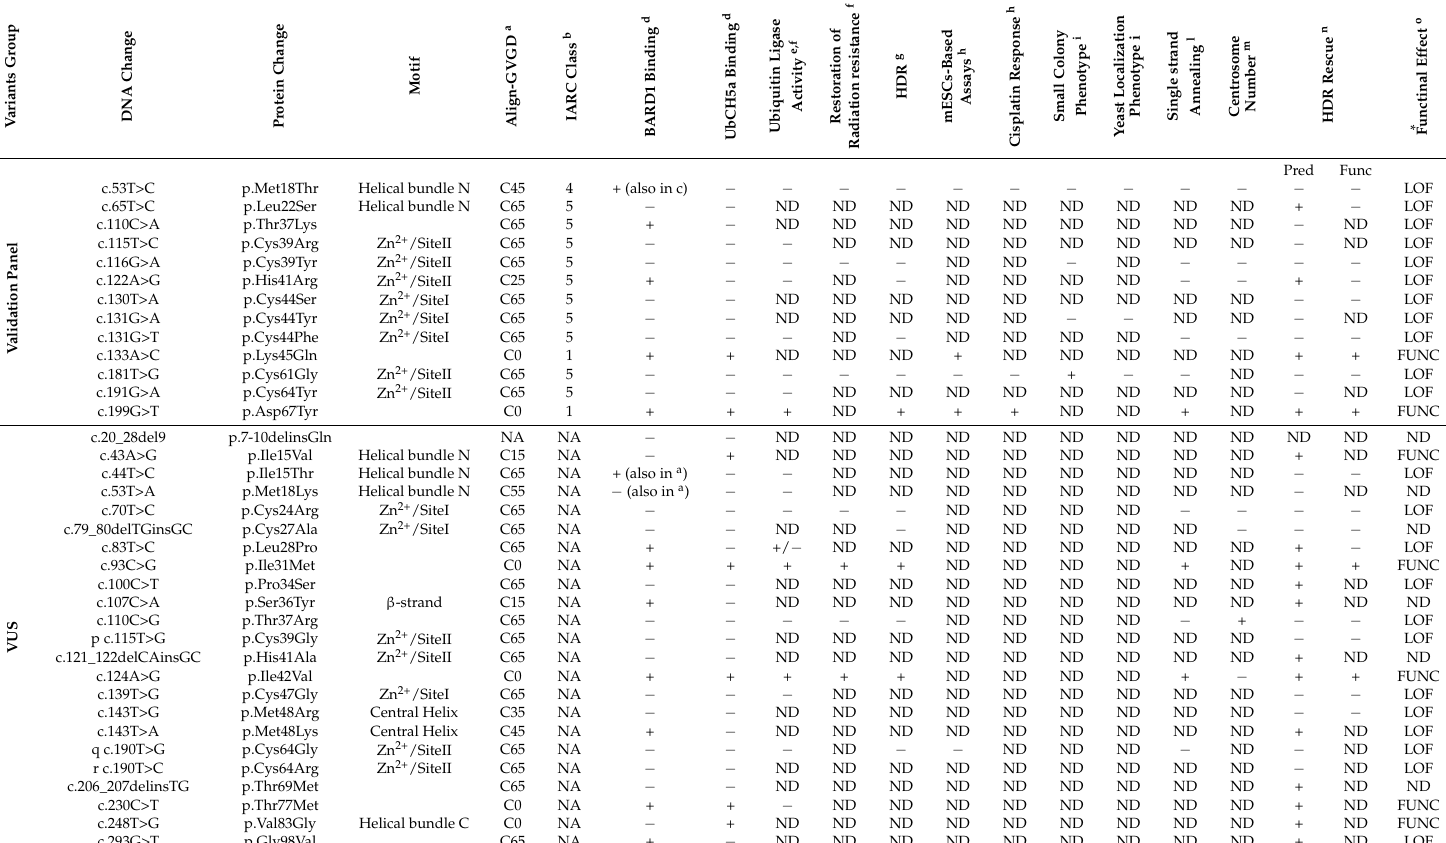
Table 3. BRCA1 variants analyzed with different functional